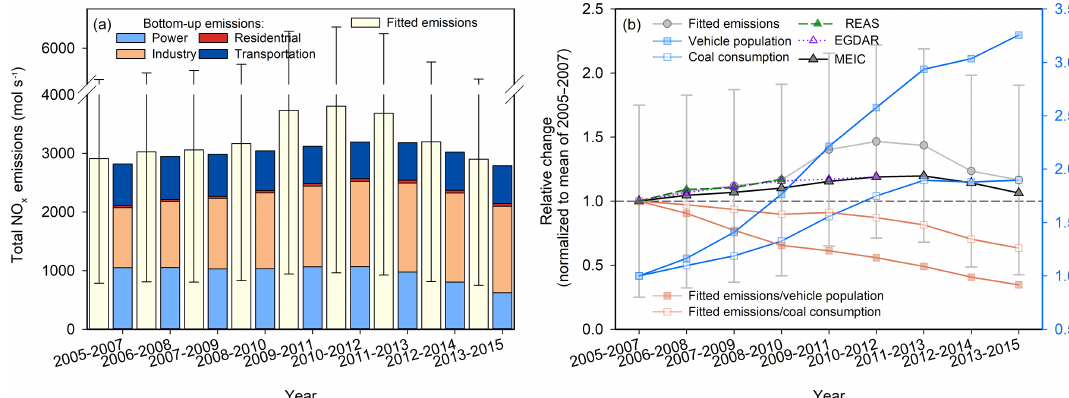
Figure 3. (a) Fitted (yellow bar) and total anthropogenic NO x emissions by sector for all investigated cities in this study during 2005 to 2015. The emissions data are derived from the MEIC model. (b) Interannual trends of the fitted (gray line) and bottom-up anthropogenic NO x emissions for selected cities with valid information on the vehicle population (blue solid squares) and coal consumption (blue open squares) from 2005 to 2015. The emissions deriving from the MEIC, REAS v2.1 and EDGAR v4.3 inventory are displayed in black, green, and purple, respectively. The pink lines denote the ratio of the fitted NO x emissions in this study to the vehicle population (solid squares) and coal consumption (open squares). The relative changes of the vehicle population and coal consumption are indicated by right axes. Error bars show the uncertainties for the fitted emissions by using this method (see Sect.